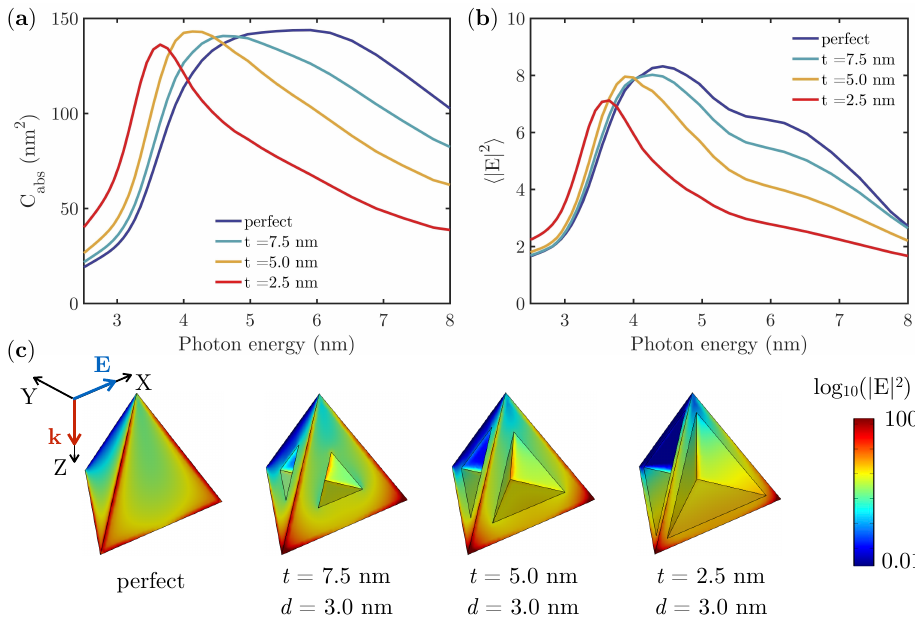
Figure 6. ( a ) Absorption cross-sections ( C abs ) of edge length L = 20 nm Rh TDs with a concavity with Figure 4. ( a ) absorption cross-sections ( C abs ) of edge length L = 30 nm Rh NCs with rounded edges increasing size t while keeping its depth constant d = 3 nm; ( b ) local field enhancement ( over the TD’s surface; ( c ) local field enhancement in logarithmic scale ( and corners with a curvature radii R c varying from 0 (perfect cube) to 15 nm (perfect sphere); ( b ) local 2 ) averaged over the corners and edges (where charge is most concentrated) of different TD when illuminated with the corresponding resonant field enhancement ( E | | the NC with different R c ; ( c ) local field enhancement in logarithmic scale ( different NCs when illuminated with the corresponding resonant wavelength.